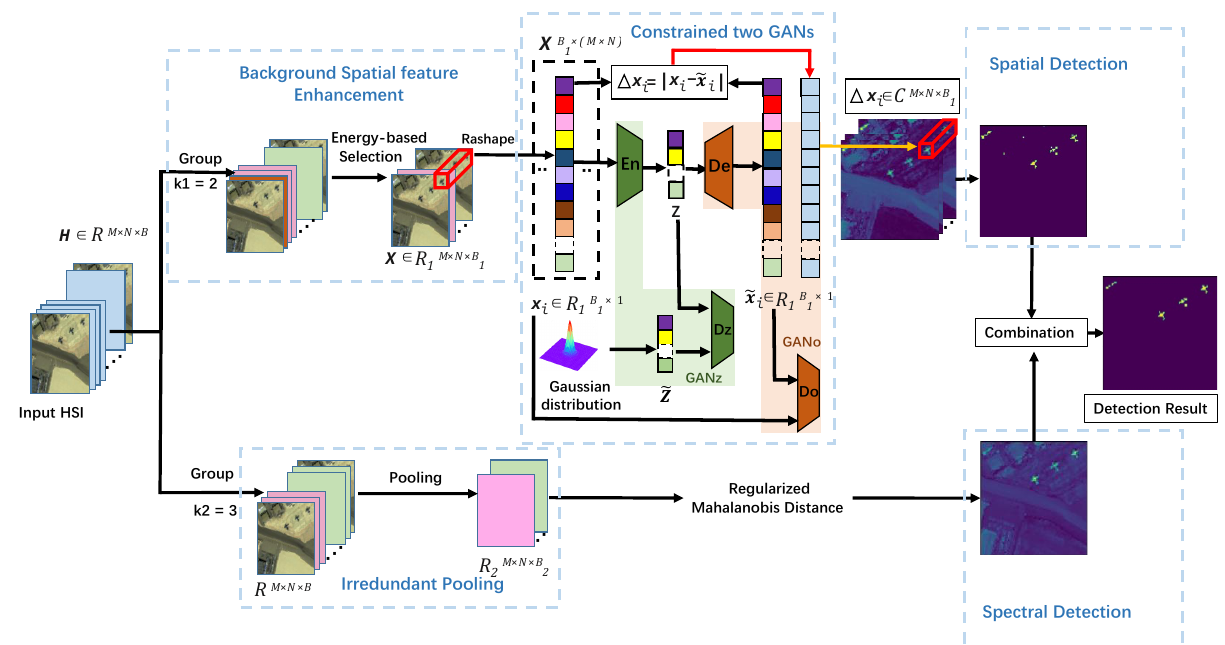
Figure 1. The architecture of unsupervised generative adversarial network with background spatial feature enhancement and irredundant pooling (BEGAIP). It consists of five portions: background spatial feature enhancement, constrained two GANs (GANz, GANo), spatial detection, irredundant pooling, and regularized mahalanobis